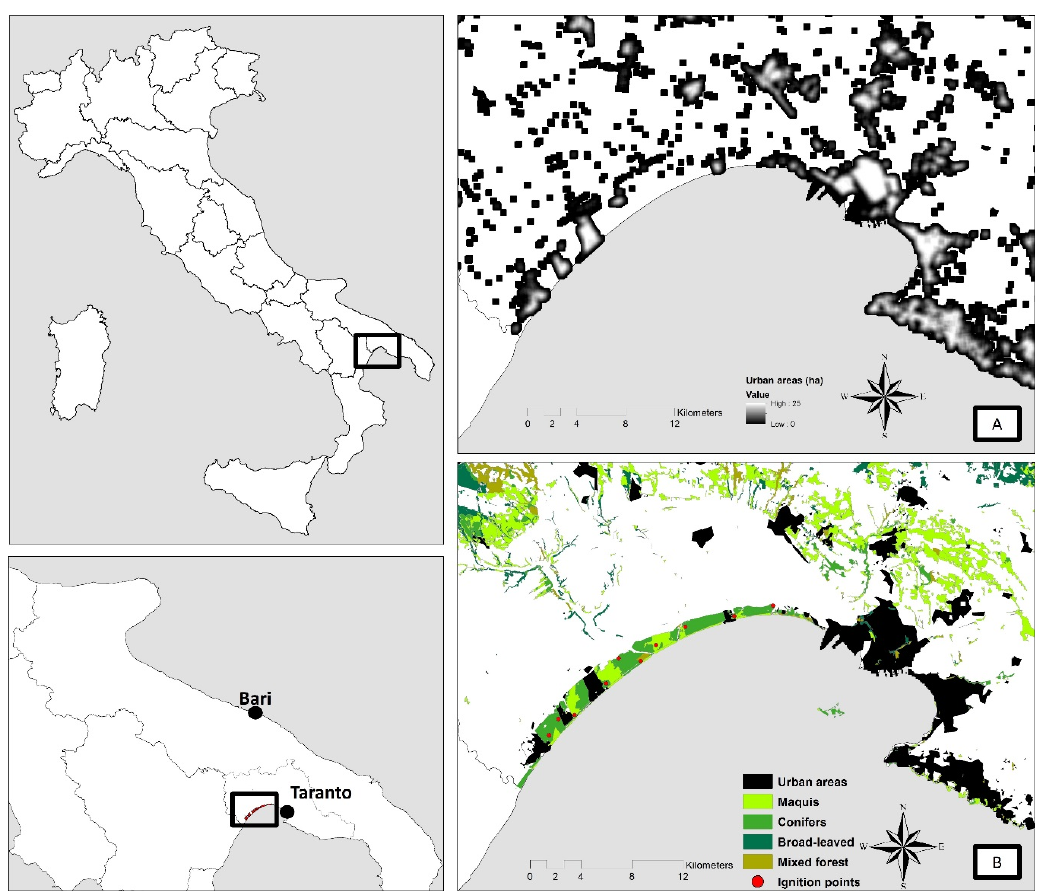
Figure 1. Location of the study area (Taranto province) in the Apulia region, southern Italy. Maps of: urban areas within the landscape ( A ) and main forest cover and potential ignition points ( B ).